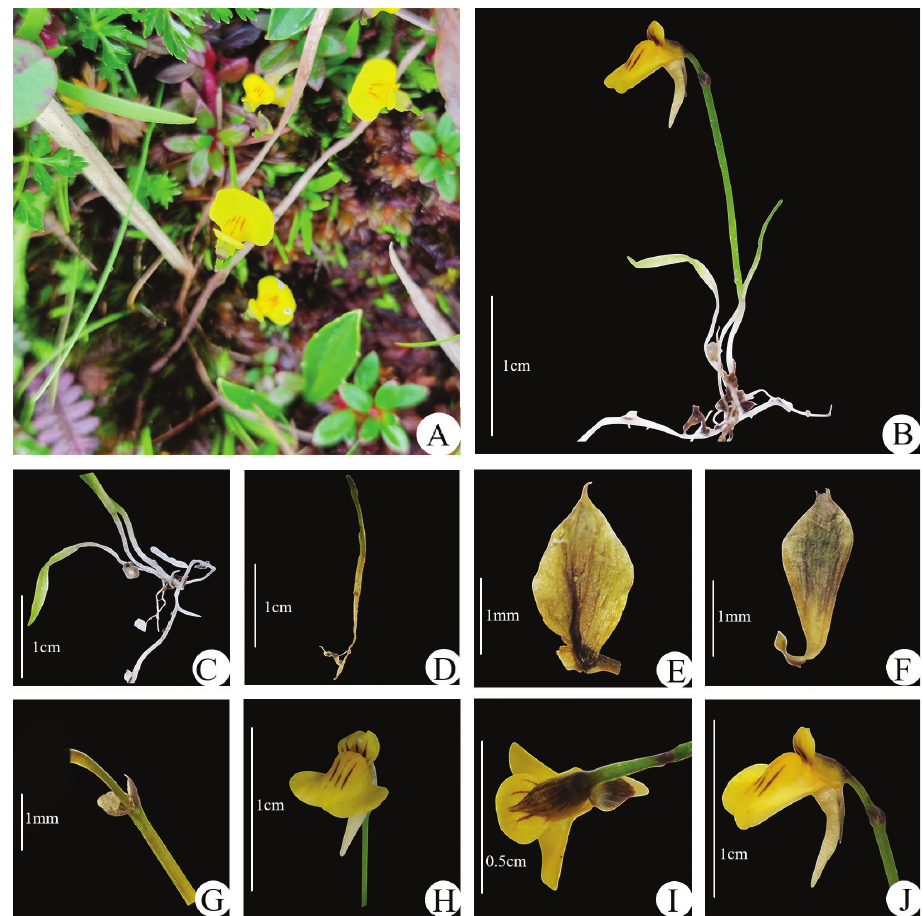
Figure 2. Utricularia lihengiae ( A–J ) A habitat B whole plant C traps and laminar leaves D leaf E calyx upper lobe F calyx lower lobe G bracts H–J frontal, dorsal and lateral view of the flower ( A–J Photos by Z.